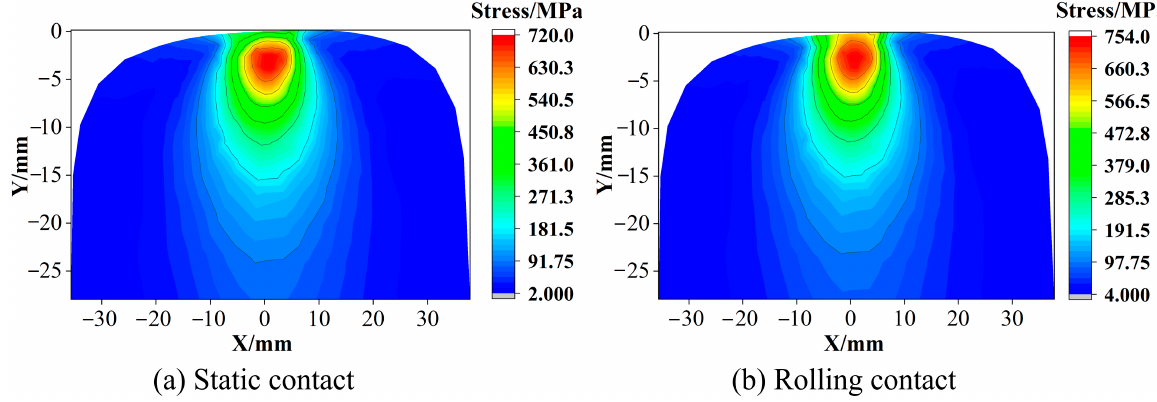
Figure 2. Stress distribution of rail cross section.